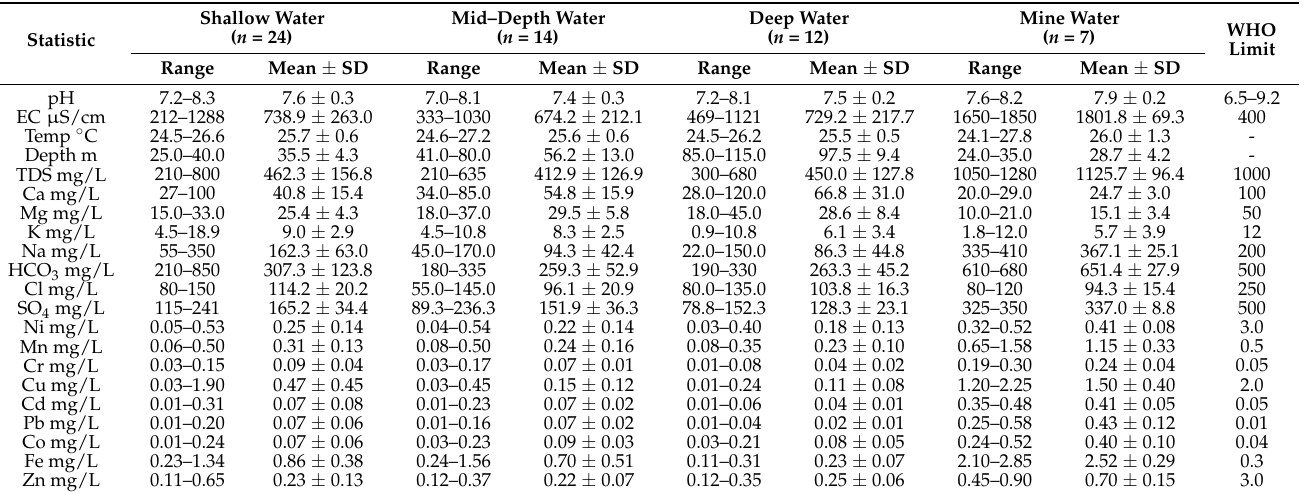
Table 1. Statistical results of PHEs and physicochemical variables in the groundwater ( n = 50) that were collected from different depths and mining areas of the Adenzai flood plain area,